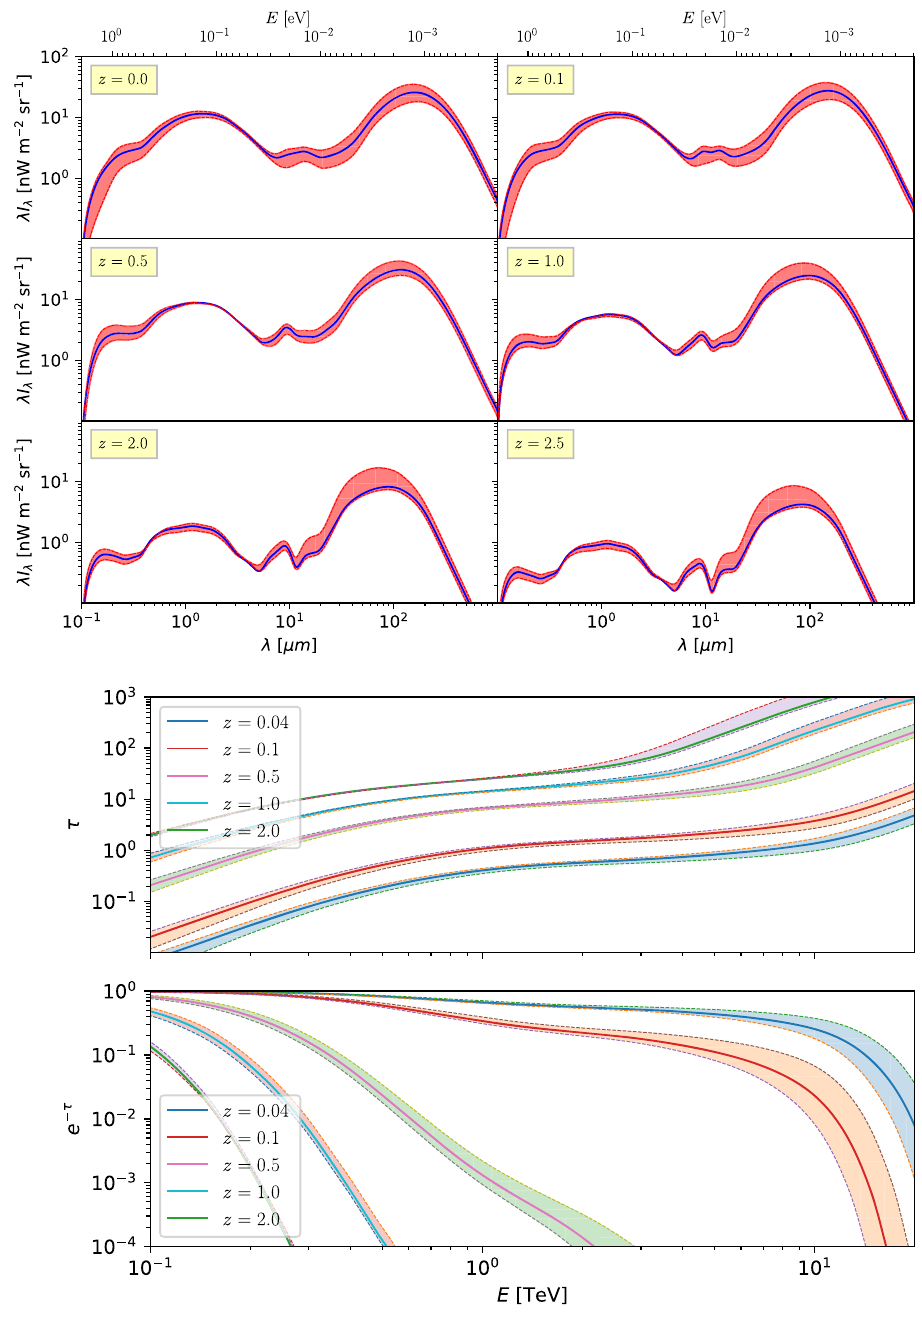
Fig. 3 The optical depth (upper panel) and the exponential of the minus optical depth (lower panel) versus energy predicted by the model of A. Domínguez et al. [50] for different redshifts z = 0 . 04 , 0 . 1 , 0 . 5 , 1 . 0 and 2 . 0. More data and details are publicly available at http://side. iaa.es/EBL/. The dashed lines and shadowed regions show the